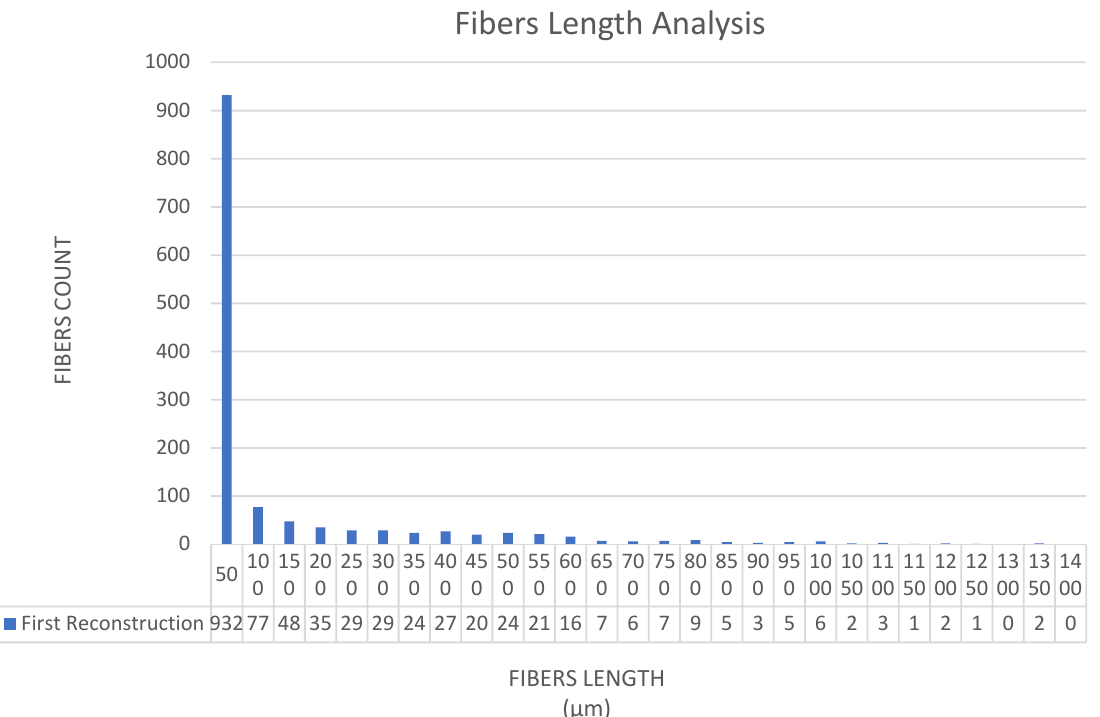
Figure 18. Statistical diagram of polyester short fiber length reconstructed by Avizo software for the first time.